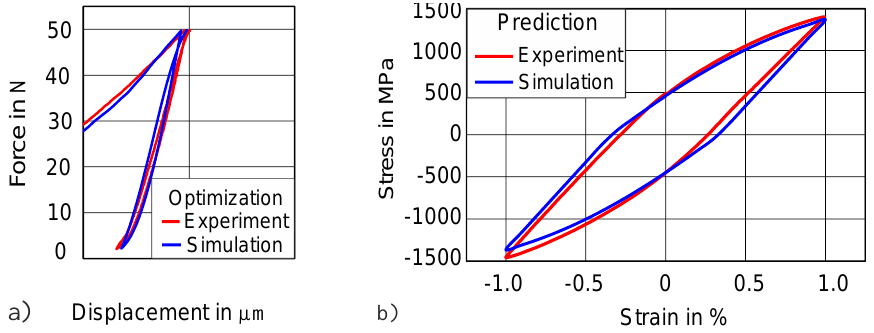
Figure 12. Transferability of method: ( a ) simulated indentation force – displacement at 50 N for 47 HRC; ( b ) prediction of uniaxial stress – strain hysteresis of 47 HRC. Table 3. Identified material parameters for 50CrMo4 (47 HRC) of force – displacement at 50 N force amplitude.